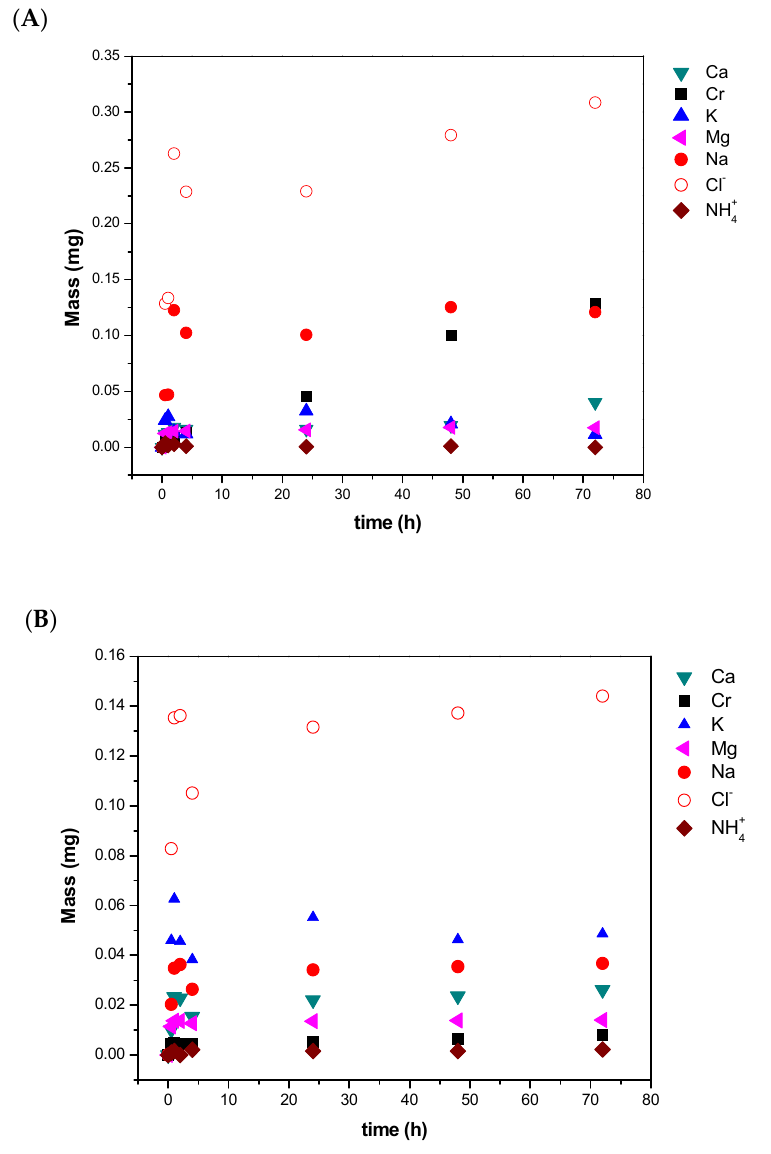
Figure 11. Mass of the compounds desorbed from the cs-PES MF 022 membrane at ( A ) pH 5.8 and ( B ) pH 2, after diafiltration of the SW30 concentrate obtained from filtration of a synthetic tannery